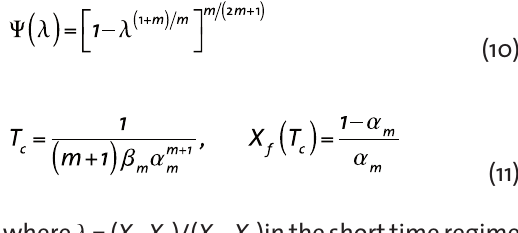
Figure 3 (left above): Variation of characteristic time with power law index. Figure 4 (right above): Time variation of the veloci- ty of the back wave for given power law index. Figure 5 (below): Time variation of the veloci- ty of the positive wave for given power law index in the short time regime (a) and in the long time regime